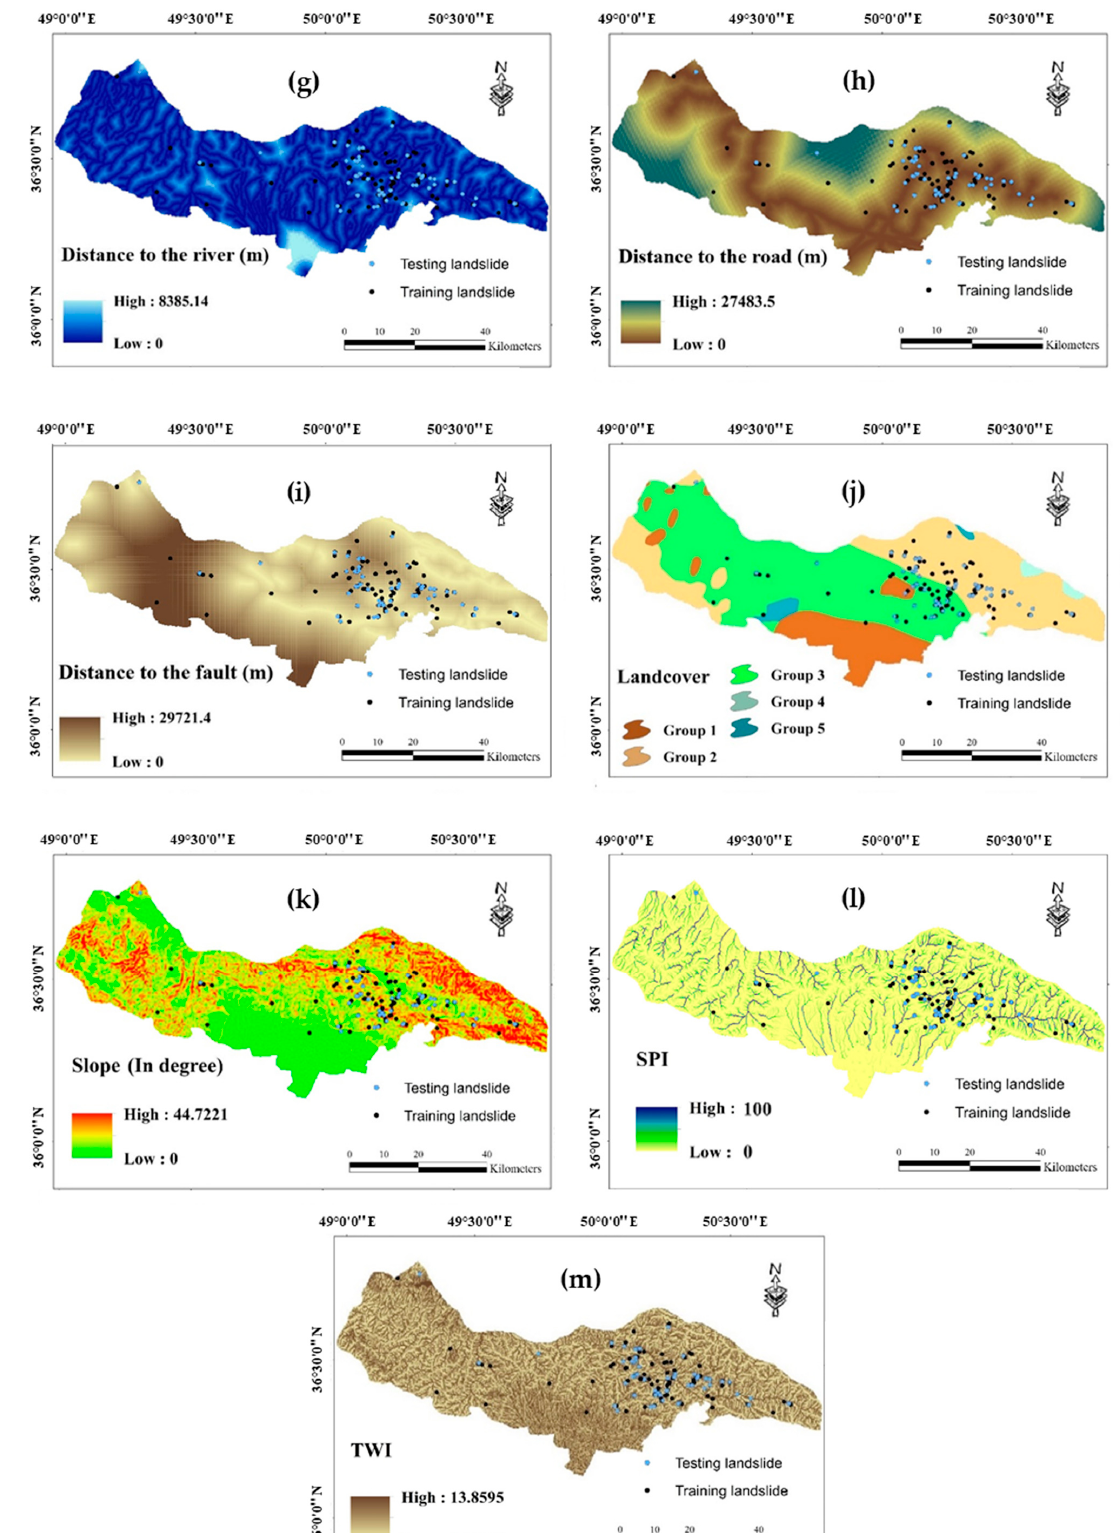
Figure 2. Landslide conditioning factor, percentage of the area for each sub-class, and the calculated FR for: ( a ) elevation, ( b ) slope aspect, ( c ) climate, ( d ) plan curvature, ( e ) soil type, ( f ) lithology, ( g ) distance to river, ( h ) distance to road, ( i ) distance to fault, ( j ) land cover, ( k ) slope degree, ( l ) SPI, and ( m )